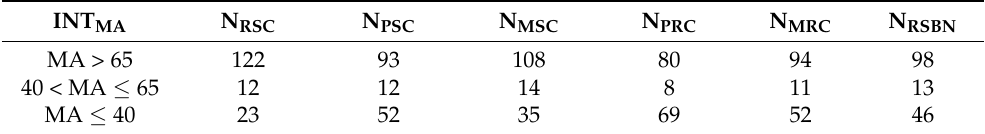
Table 4. MA denotes the percentage of non-hydrogen atoms within 0.6 Å of the published atomic coordinates, represented by the metric MA. The number of structures (NRSC, NPSC, NMSC, NPRC, NMRC, NRSBN) with MA belonging to each MA interval (INTMA) are shown *. N